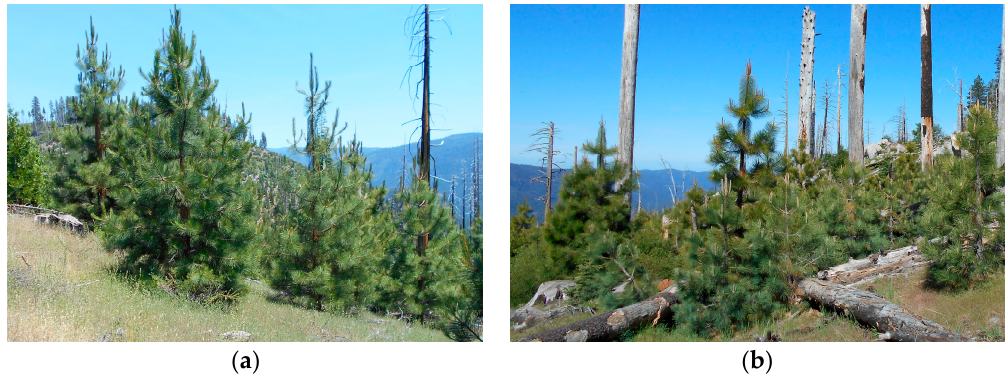
Figure 4. Comparison of a traditional, evenly spaced plantation ( a ), and a novel clustered arrangement ( b ) in the mixed-conifer forest region of the Sierra Nevada, Eldorado National Forest.